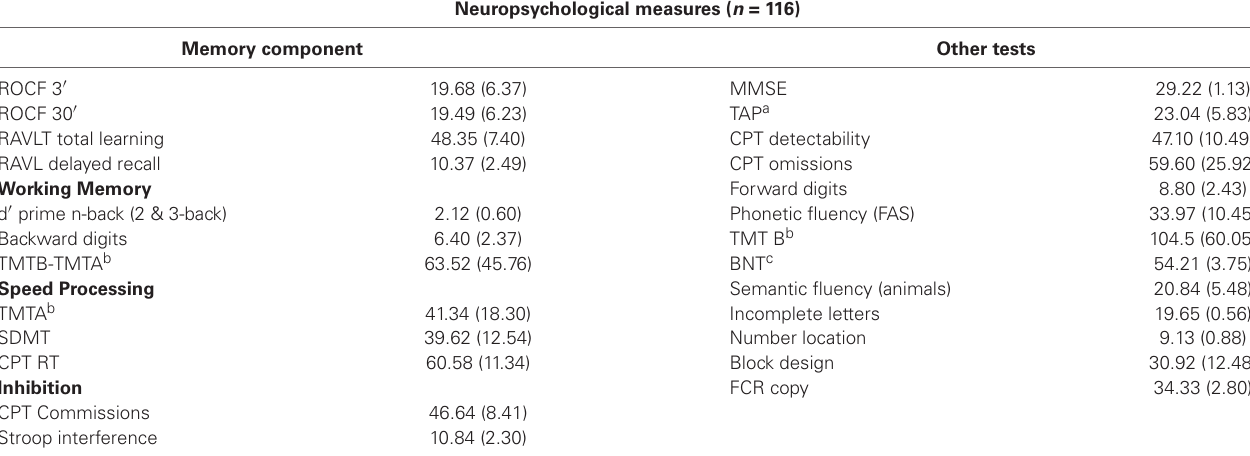
Neuropsychological measures ( n = 116)